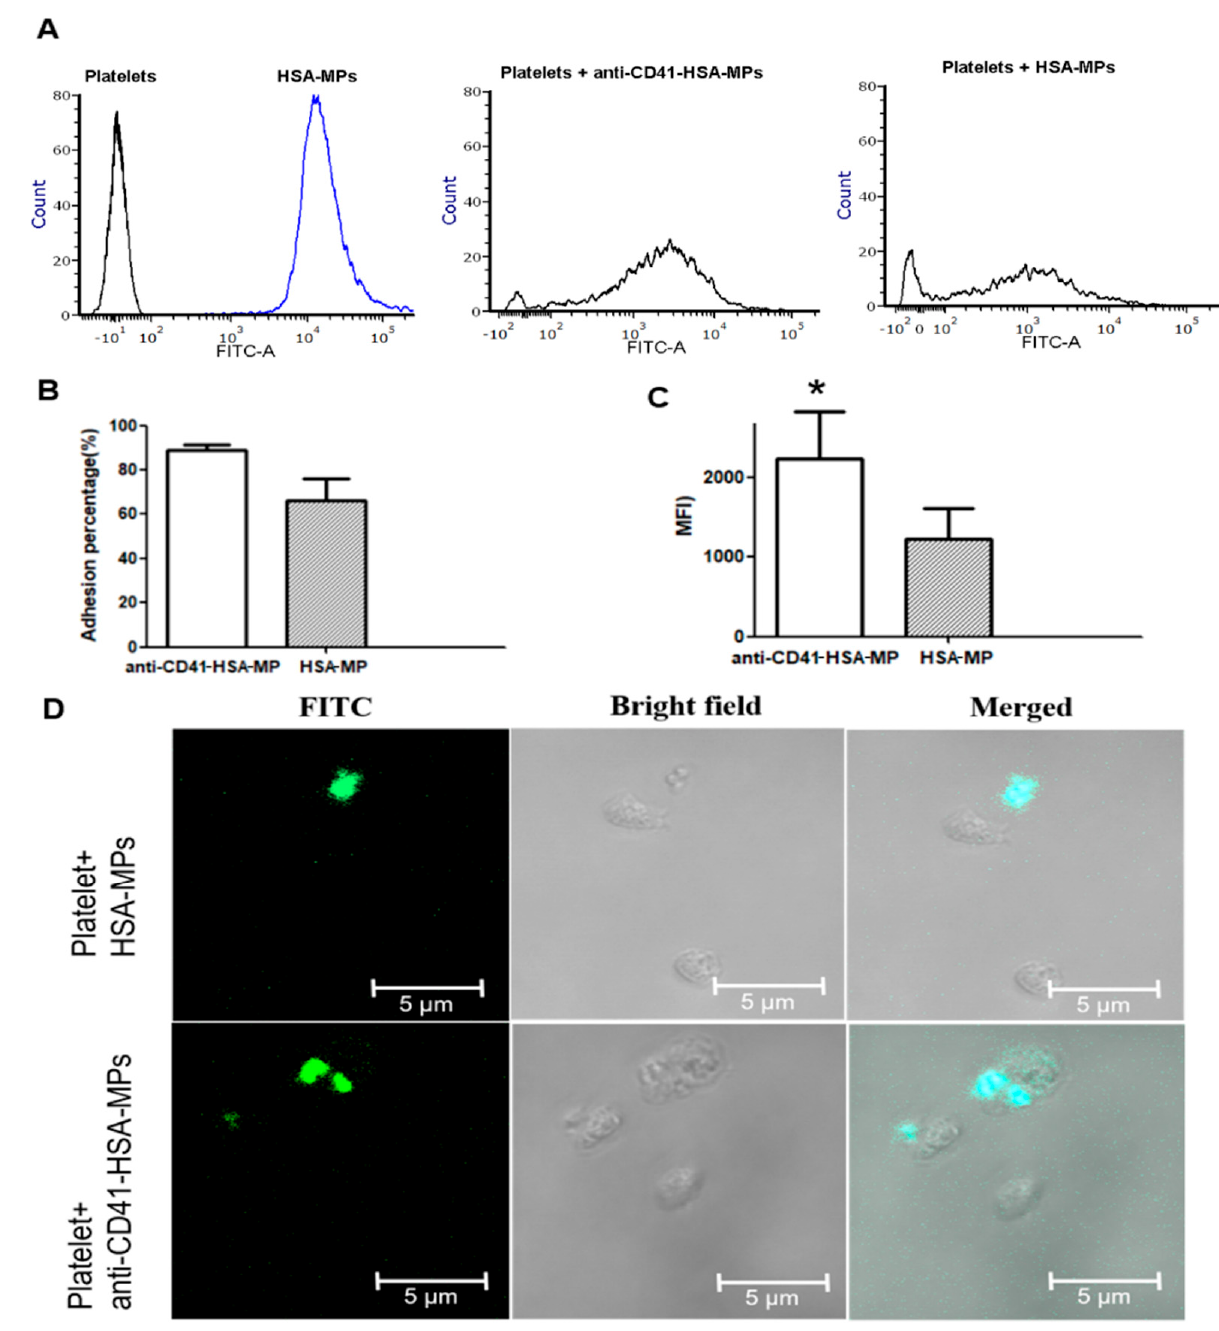
Figure 3. Adhesion of anti-CD41-HSA-MPs to platelets ( A ). Flow cytometry histograms of the fluorescence intensity in the platelet or FITC-HSA-MP populations (black line: platelets only; blue line: FITC-HSA-MPs only), and in the populations of platelets incubated with FITC-HSA-MPs or platelets incubated with anti-CD41-FITC-HSA-MPs, respectively. ( B ). Percentage of platelets with adhered FITC-HSA-MPs or anti-CD41-FITC-HSA-MPs. ( C ). Mean fluorescent intensity (MFI) values of the platelet population in the FITC channel. * p < 0.05. ( D ). Representative confocal laser scanning microscopy images of HSA-MPs and anti-CD41-HSA-MPs with